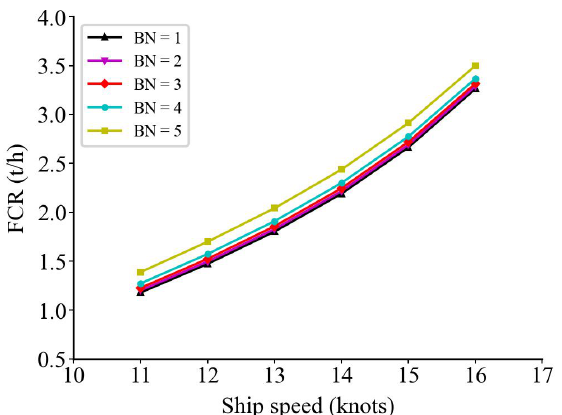
Figure 14. Additional fuel consumption for wind in headwind